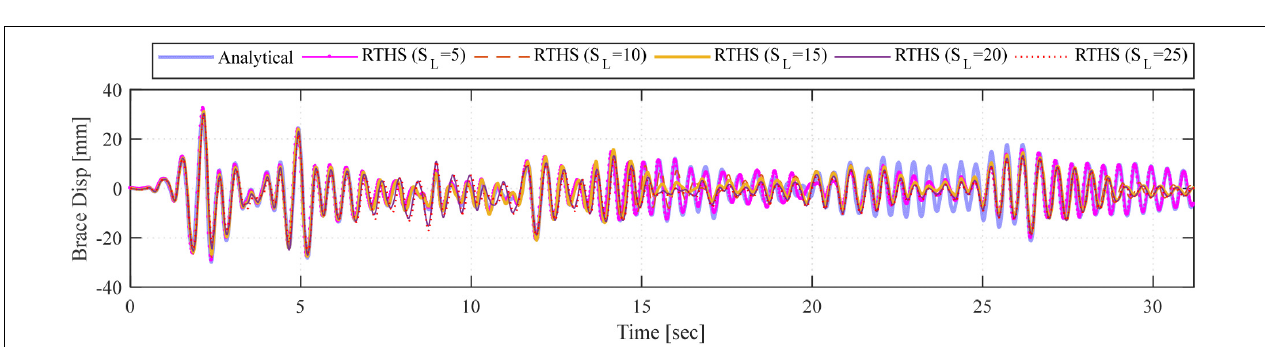
FIGURE 17 | Comparison of brace displacements from online RTHS tests without using ATS compensator (for different geometric scales) against pure analytical solution.